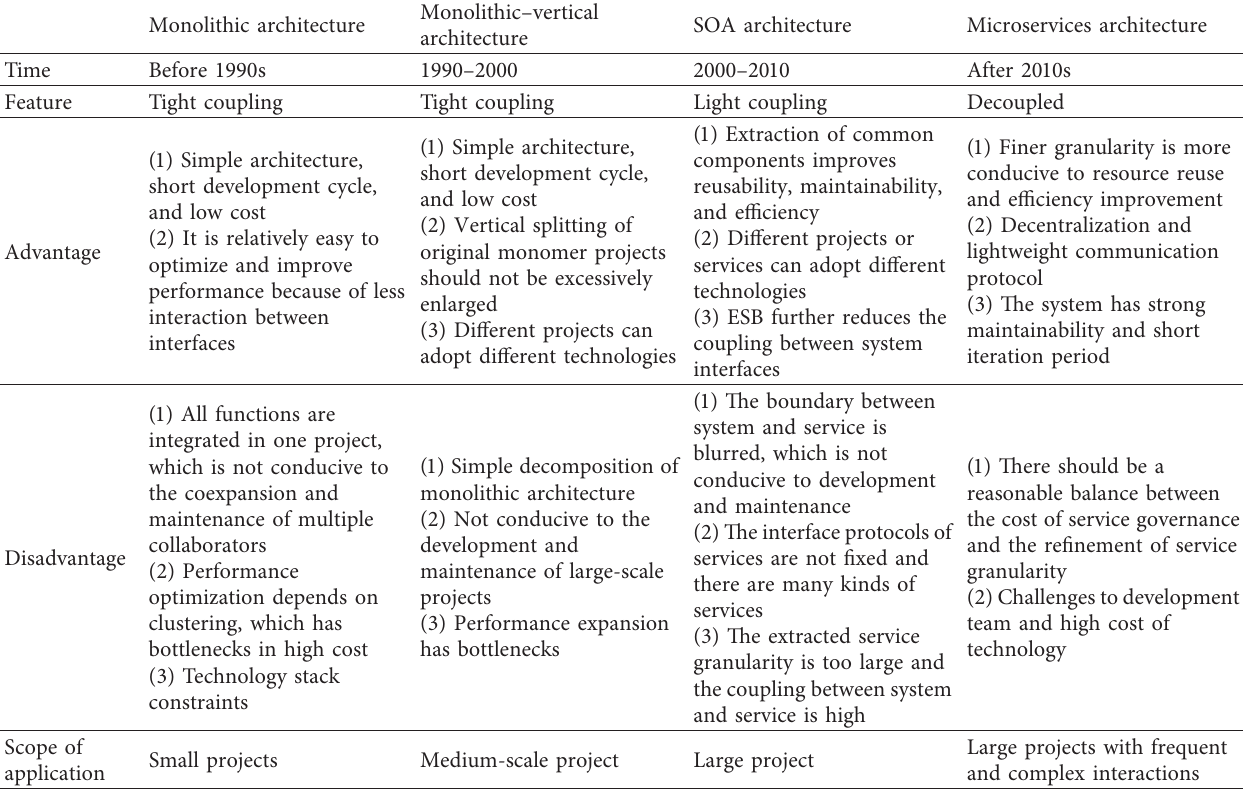
Table 1: Key differences between four